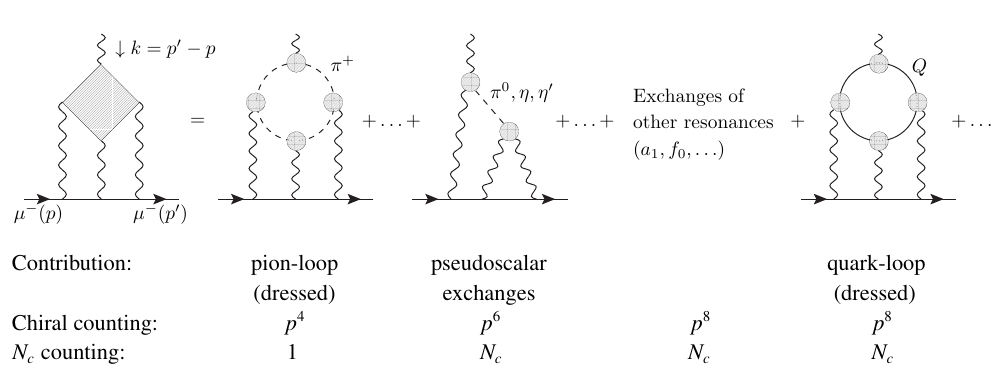
hadronic picture, the four-point function is decomposed into single-meson exchanges and loops of hadrons, e.g. pions. Often the QCD short-distance part is modelled by a dressed constituent quark loop, which raises issues of double counting. The couplings of the hadrons (and the constituent quarks) to the photons involve, in general, momentum dependent vertex functions (form factors). The di ff erent contributions have been classified in Ref. [20] according to their leading order in the chiral expansion p 2 and their large- N c counting to bring some order and systematics into the